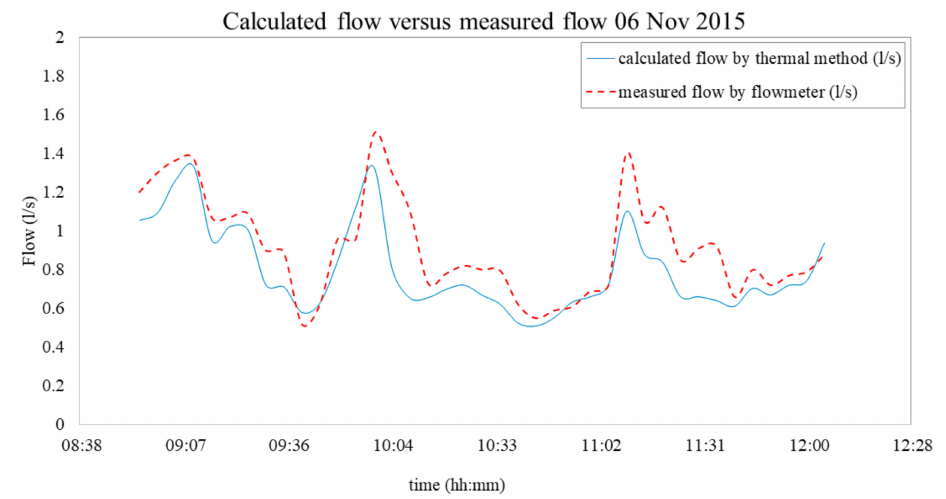
Figure 8. Measured flow by the flowmeter and calculated flow by DTS method versus time on 6 November 2015 at x = 1727